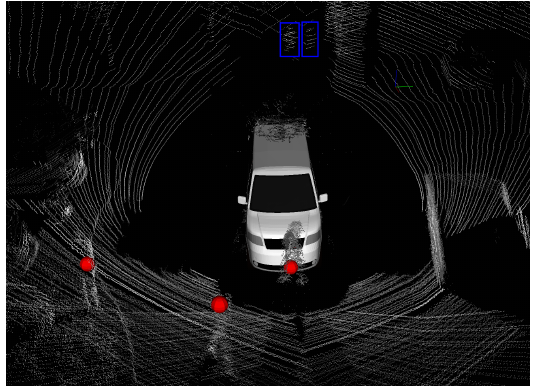
Figure 5. Pedestrian detection using the front LiDAR sensors of MODISSA. Red dots are correct detections; blue rectangles are missing detections. The scene corresponds to Figure 4 and shows the same moment of the same measurement